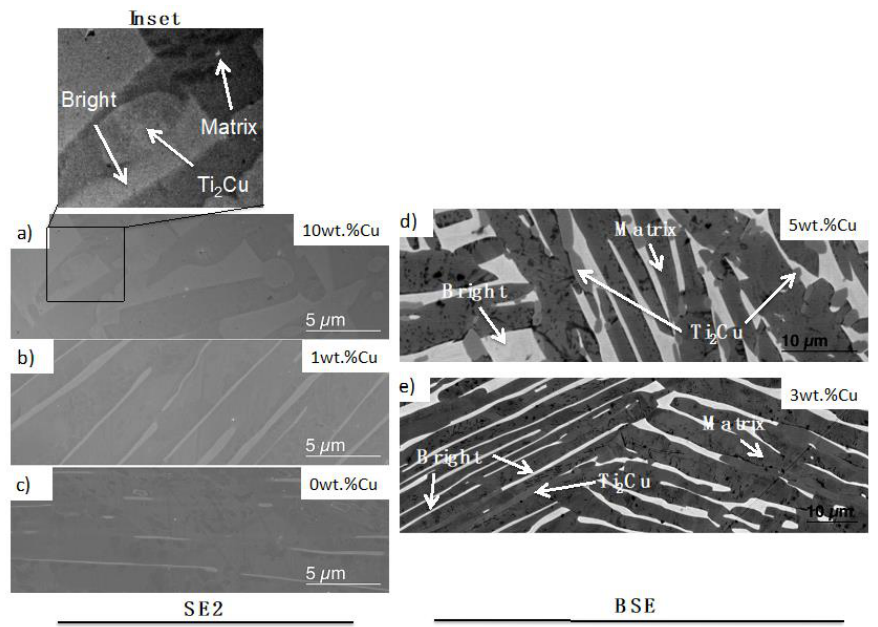
Figure 3. SEM micrographs showing ( a ) 10 wt.% Cu alloy with Inset showing three crystal phases, ( b ) 1 wt.% Cu alloy, ( c ) 0 wt.% Cu alloy ( d ) 5 wt.% Cu alloy with 3 crystal phases shown ( e ) 3 wt.% Cu alloy with three crystal phases